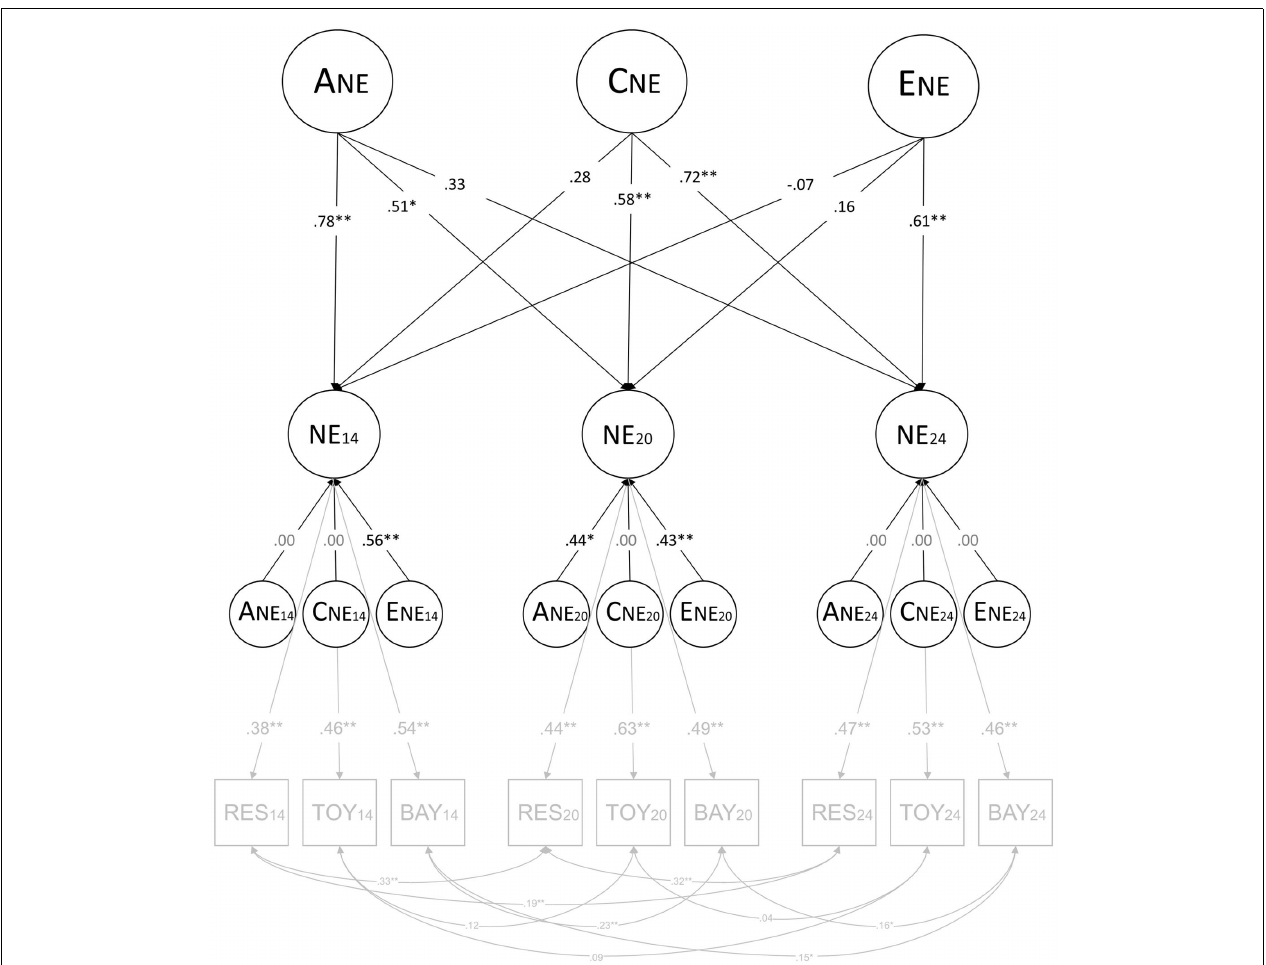
FIGURE 2 | Results of full independent pathway model. A NE = common genetic influences; C NE = common shared environmental influences; E NE = common non-shared environmental influences; A NE14 , A NE20 , and A NE24 = genetic influences specific to 14, 20, and 24months; C NE14 , C NE20 , and C NE24 = shared environmental influences specific to 14, 20, and 24months; E NE14 , E NE20 , and E NE24 = non-shared influences specific to 14, 20, and